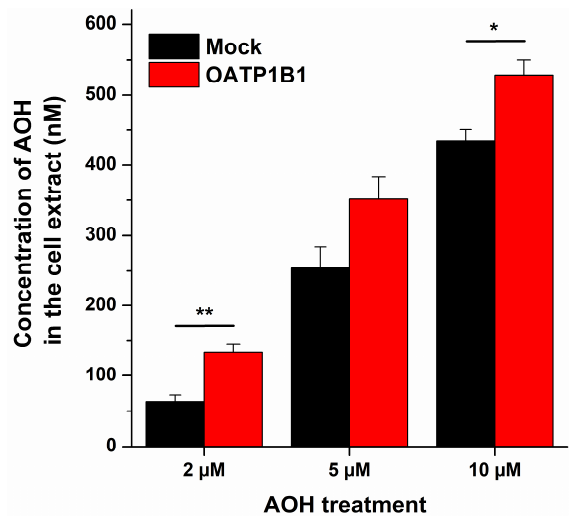
Figure 4. AOH concentrations in A431 cell extracts after 15 min incubation with 2, 5, or 10 μM mycotoxin solutions. AOH was quantified by HPLC-FLD (see experimental details in Sections 2.6 and 2.7; n = 6; * p < 0.05, ** p < 0.01).